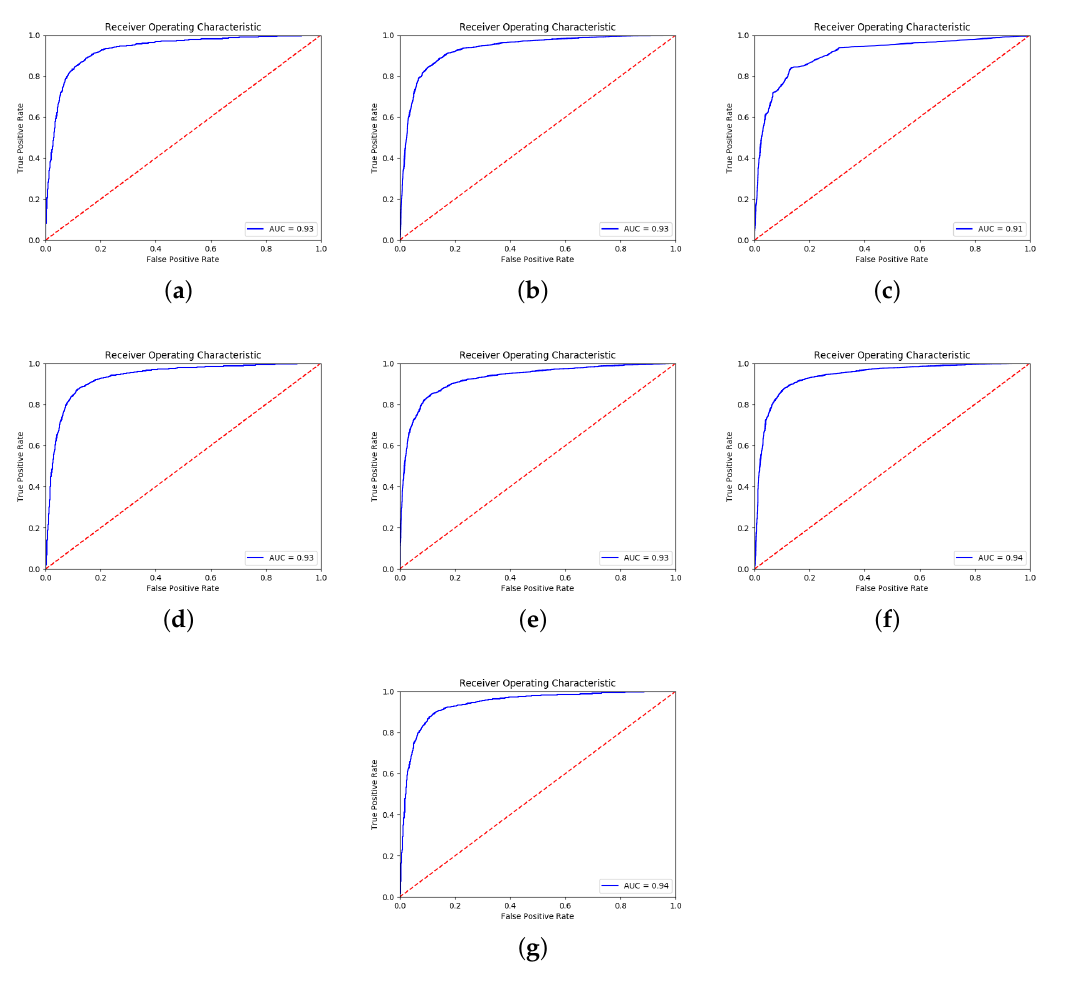
Figure 2. ROC curves obtained using each measures to predict the accuracy on the SVHN validation set. Measures e , s , d img , g , d feat , mix 1 and mix 2 are, respectively, plotted in ( a – g ).